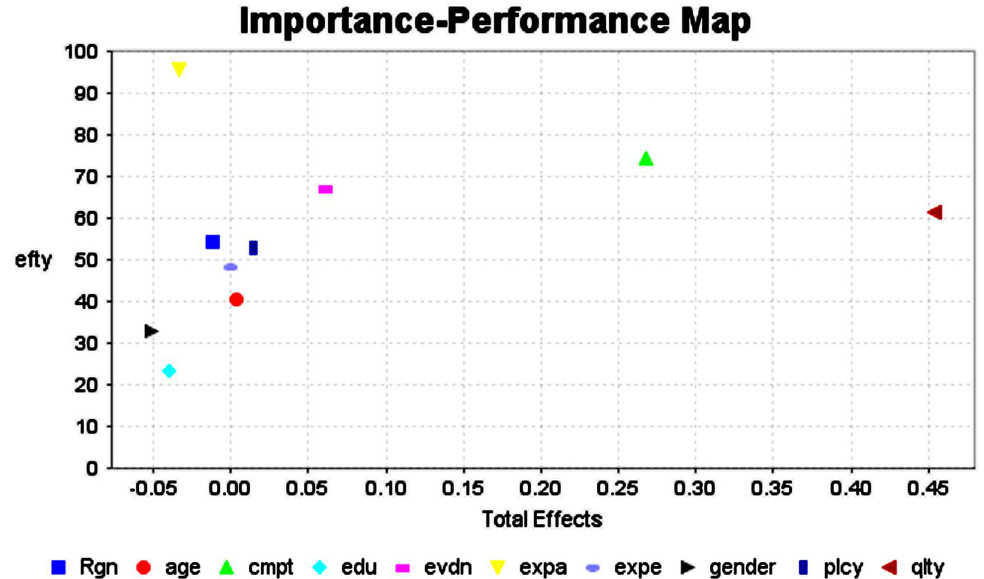
Figure 2. Importance-performance matrix